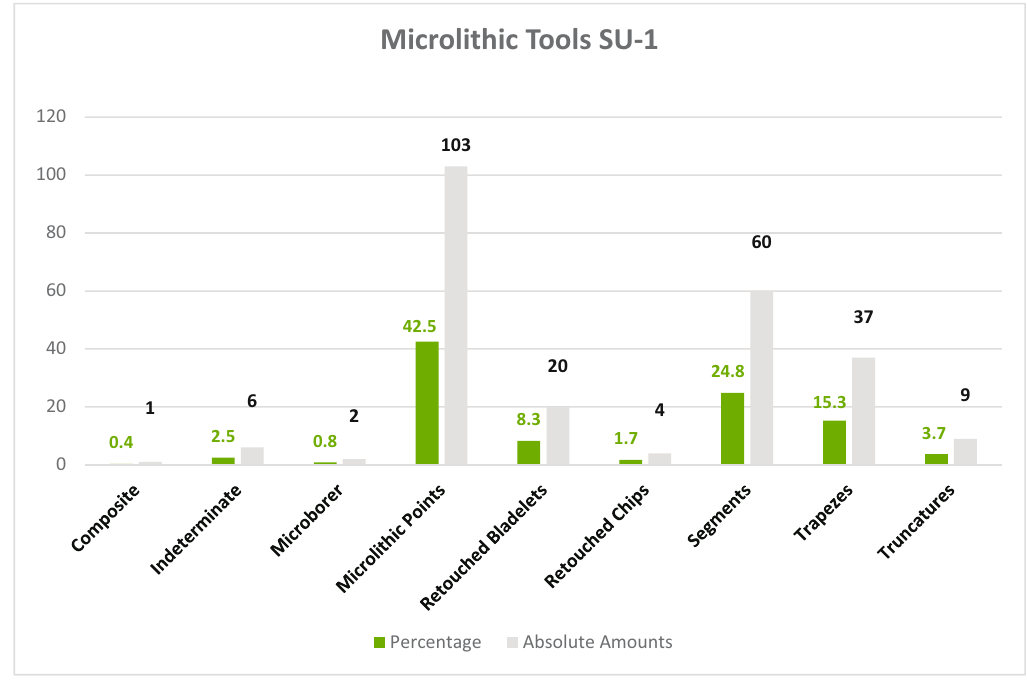
Figure 7: Microlithic tools SU - 1 ( percentage and absolute amounts ) .